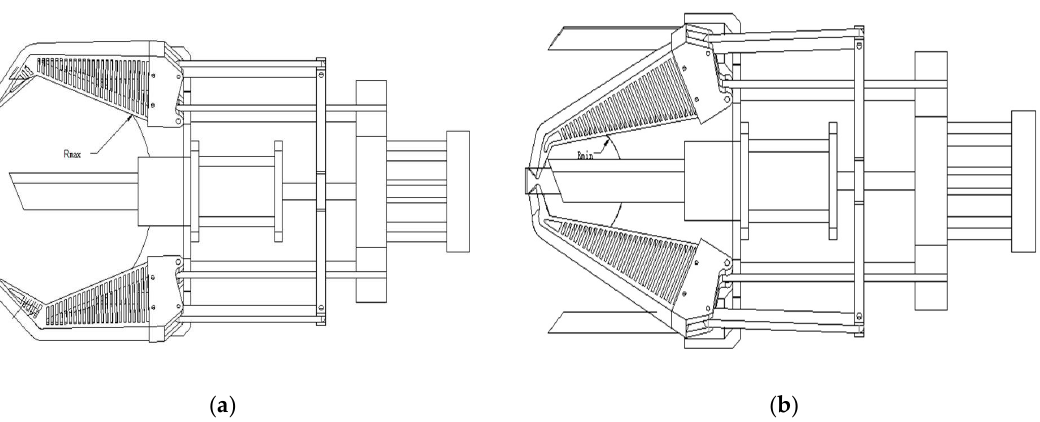
Figure 2. Diagram of citrus picking at different sizes and diameters. ( a ) Large-diameter citrus picking map; ( b ) Small-diameter citrus picking map.